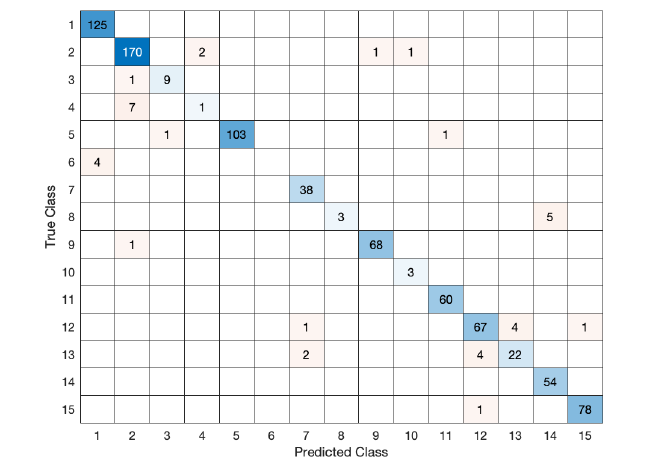
Figure 15. This figure shows the confusion matrix in the case of a subarea in which the lambda value is equal to